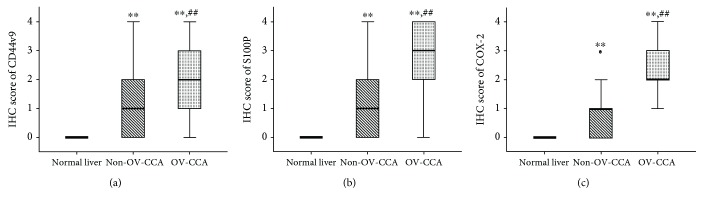
Box plots of CD44v9 (a), S100P (b), and COX-2 (c) staining in human liver tissues categorized by IHC score. The horizontal bold lines represent the median value, and the lower and upper boxes represent the 25th and 75th percentiles, respectively. The whiskers represent the range of data, and the circle is an outlier. A Kruskal-Wallis test was used to test for a significance difference among the three groups, and a Mann-Whitney U test was used to compare two groups with an adjustment of p value by the Bonferroni method. ∗∗
p < 0.01 compared to the normal liver group and ##p < 0.01 compared to the non-OV-CCA group.